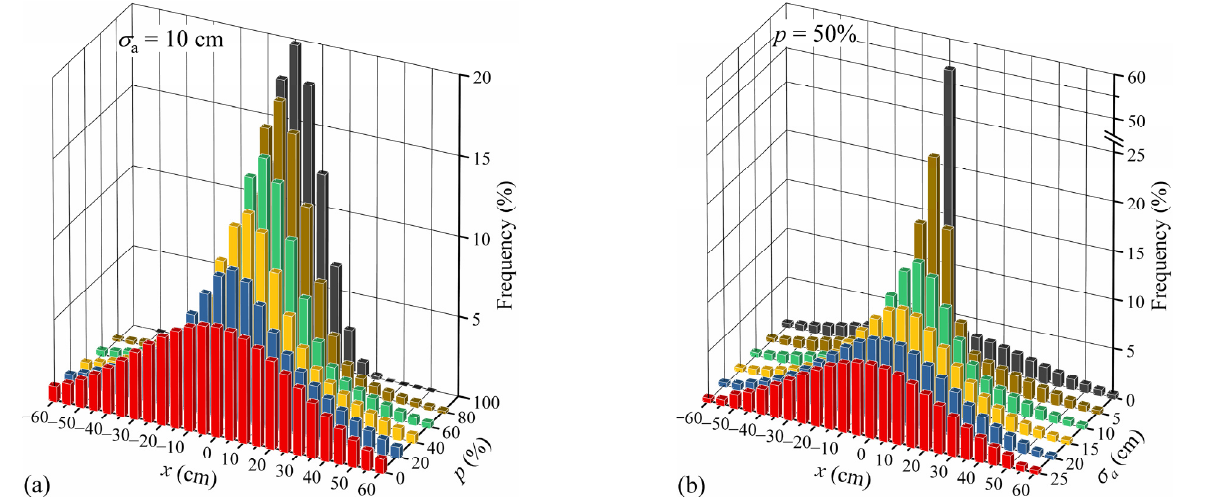
Figure 8. Transverse distribution frequency of the mixed traffic flow: ( a ) Case of σ a = 10 cm; ( b ) Case of p = 50%.